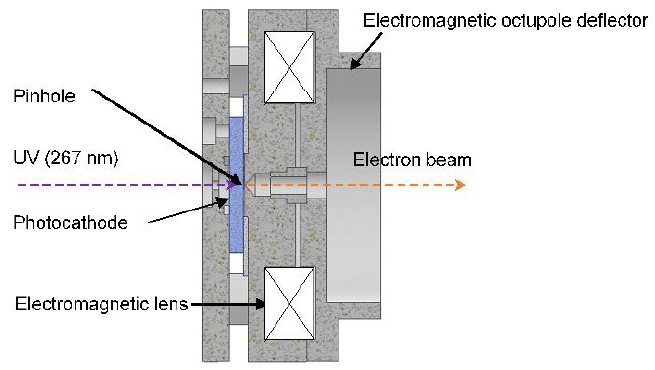
Figure 4. The cross section of the photocathode-type pulsed electron